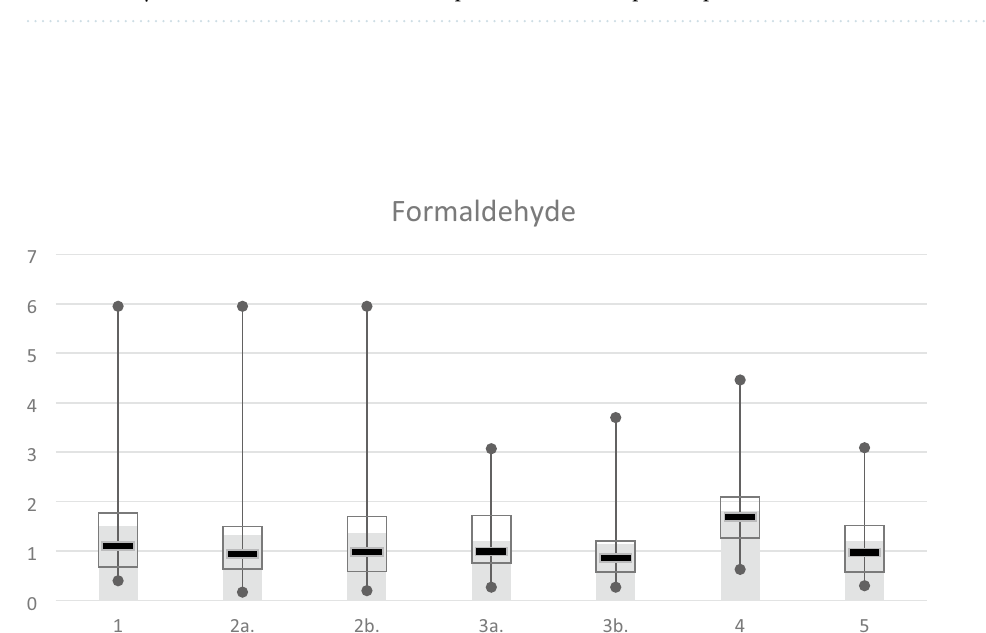
Table 3. The analysis of the concentration number of particulate matter detected during the use of electrocautery knife at different locations. Unit: particles/ft 3 . † 0.05 < p < 0.1,*p < 0.05.